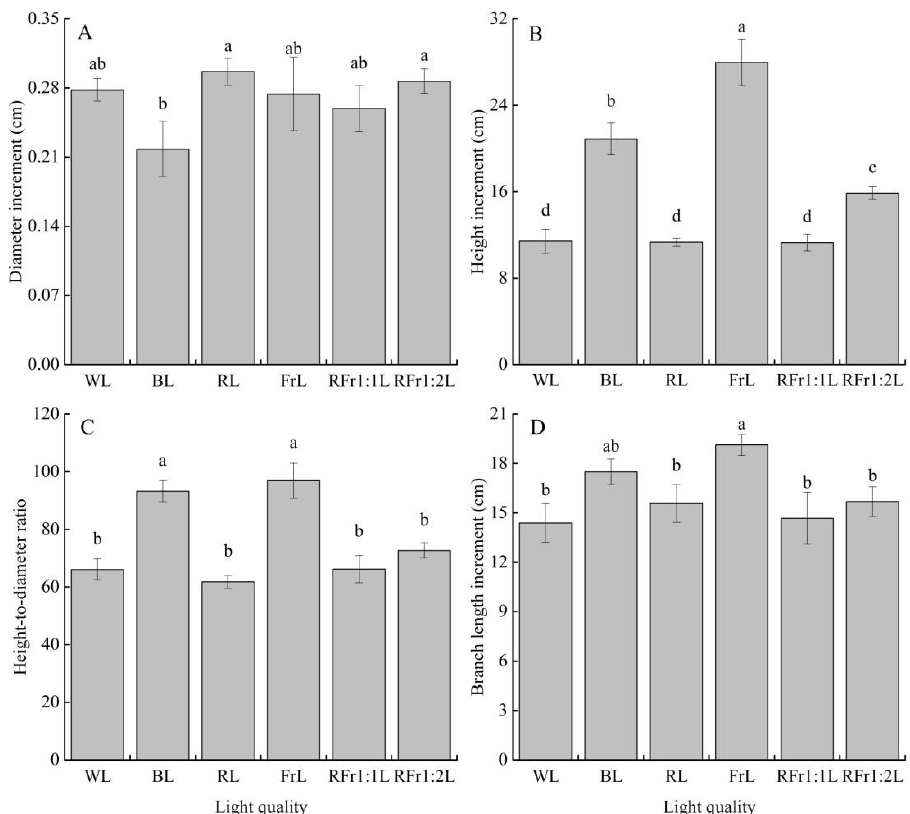
Figure 1. Diameter increment ( A ), height increment ( B ), height-to-diameter ratio ( C ), and branch length increment ( D ) of Cunninghamia lanceolata (Lamb.) Hook. seedlings under different light quality treatments. Bars represent average ± standard error ( n = 6). Different lowercase letters indicate significant differences among treatments: WL, multi-wavelength white light treatment; BL, monochromatic blue light treatment; RL, monochromatic red light treatment; FrL, monochromatic far-red light treatment; RFr1:1L, a mixed red and far-red light at 1:1 treatment; RFr1:2L, a mixed red and far-red light at 1:2 treatment.